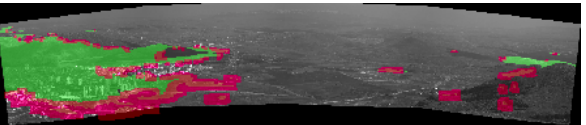
Figure 2. Moving Border of the Cloud Shadow Illustration